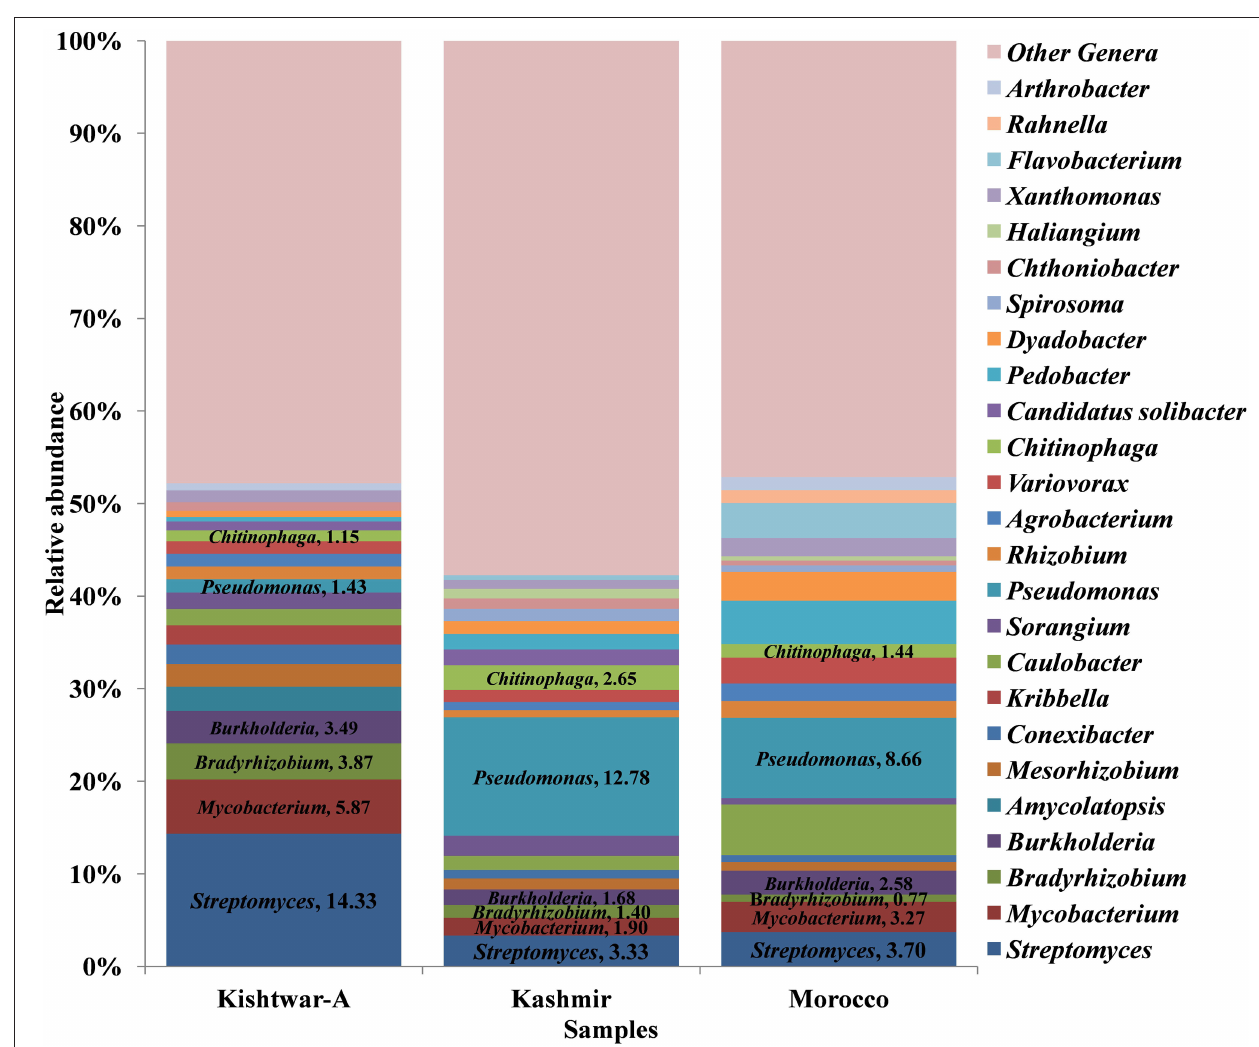
FIGURE 9 | Relative abundance of top 25 genera cataloged from cormosphere of all the three geographical locations (a total of 73 genera were cataloged from three geographical locations: Kishtwar-A, Kashmir, and Morocco). Streptomyces was the dominant genera in Kishtwar-A followed by Mycobacterim , Bradyrhizobium , and Burkholderia. Pseudomonas was the dominant genera in both Kashmir and Morocco followed by Streptomyces , Chitinophaga , and Sorangium in Kashmir and Caulobacter , Pedobacter , and Flavobacterium in